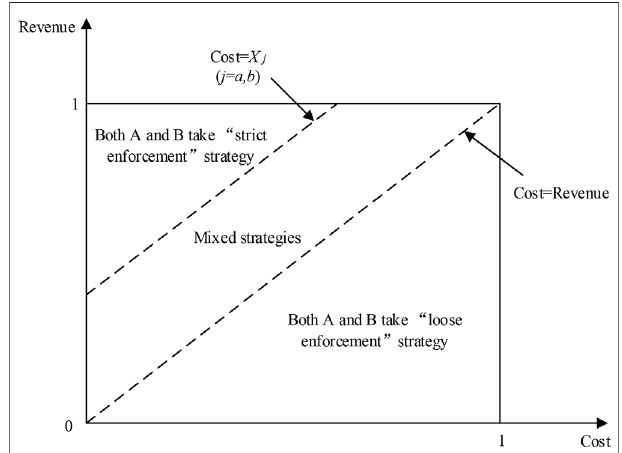
FIGURE 1 | The strategies of local governments under different conditions. The mixed strategy means under a certain possibility government Atake “ strictenforcement ” andBtake “ looseenforcement ” ,alternative,Btake “ strict enforcement ” and A take “ loose enforcement ” .